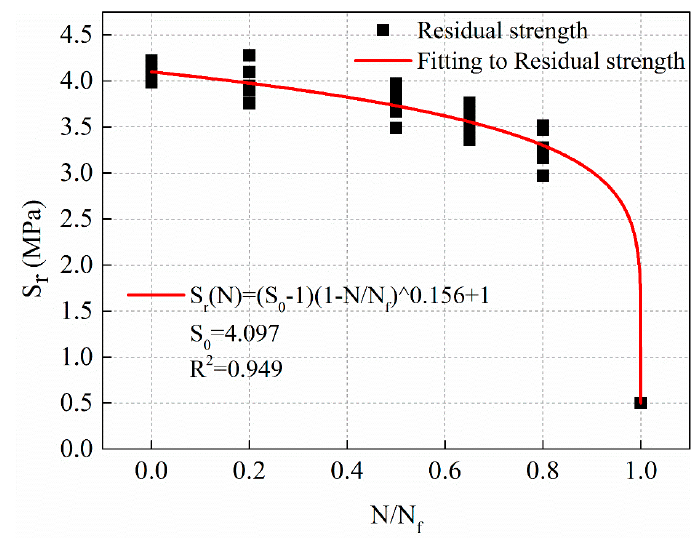
Figure 11. The decay law of residual strength with stress levels of 0.5 MPa.